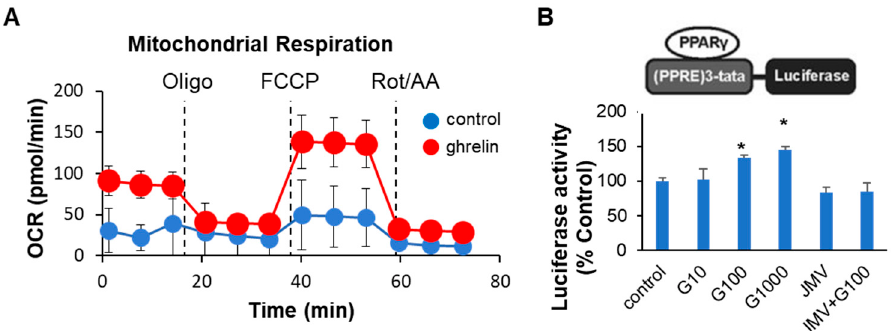
Figure 4. Ghrelin increases mitochondrial respiration and dose-dependently activated PPAR γ transcription in Caco-2 cells. ( A ) Caco-2 cells were treated with vehicle or 100 nM ghrelin for 24 h. ATP synthase inhibitor oligomycin (Oligo), mitochondrial uncoupling reagent FCCP, and electron transport chain inhibitors rotenone/actinomycin A (Rot/AA) were added at indicated times. Error bars represent SD in 12 replicates. ( B ) PPRE-luciferase plasmids were transiently transfected into Caco-2 cells for 48 h. Cells were then treated for 2 h with 10, 100 or 1000 nM of human acyl-ghrelin (G). JMV: 3 uM of Growth hormone secretagogue receptor antagonist JMV 2959. Error bars represent SEM, experiments performed in triplicate, repeated 2 times. Data were analyzed with one-way ANOVA (treatment) followed by Tukey’s post-hoc tests. * p < 0.05 vs. control group. OCR: oxygen consumption rate; PPRE: peroxisome proliferator response element.